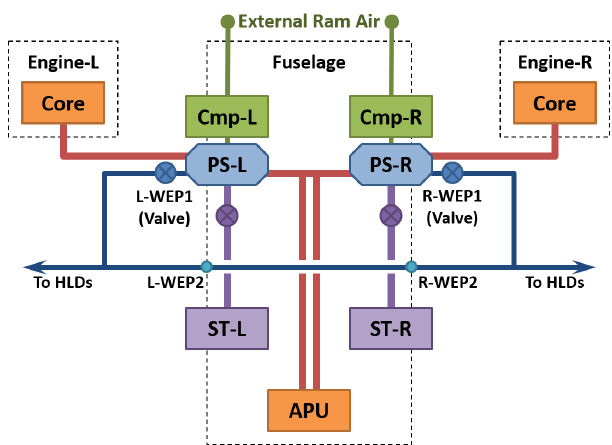
Figure 5. Redundancy-driven HLAFC system architecture layout considered in this work. Illustration pertains directly to A4; for A1–A3, connections to the relevant supply sources are omitted.